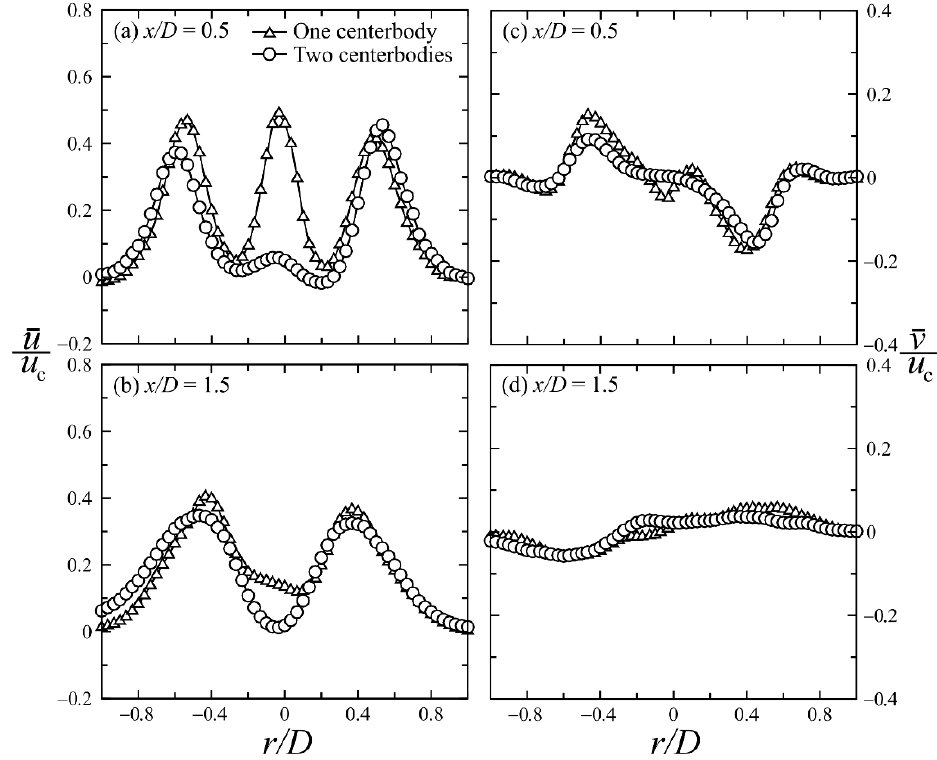
Figure 8. Radial distributions of normalized time-averaged velocities at x/D = 0.5 and 1.5. Re c = 280, Re a = 480, and S = 0.432. ( a , b ) Axial component, ( c , d ) radial component. Figure 9a,b show the normalized axial fluctuation velocities u (cid:48) / u c distributed in the radial direction at axial stages x/D = 0.5 and 1.5, respectively. At low axial levels, the axial fluctuation velocity profile exhibits quad-peak values in both the one- and two-centerbody cases. These peak values of fluctuation velocities exhibit features of inner and outer local maxima. For each dual-peak velocity profile shown in Figure 9a,b, two inversion points (i.e., inner and outer) appear to associate each axial mean velocity peak. These inversion points induce the local maxima of fluctuation intensities. In the case of one centerbody, ( u (cid:48) / u ) exhibits high values in the range of − 0.2 ≤ r / D ≤ 0.2 around the center jet axis and c decreases with increasing the axial level. For instance, the maximum values of u (cid:48) / u c are about 0.55 (Figure 9a) and 0.24 (Figure 9b) at ( r/D , x/D ) ≈ (0, 0.5) and ( − 0.1, 1.5), respectively. In the case of two centerbodies, u (cid:48) / u c exhibits lower values than those in the case of one centerbody in the region near the x